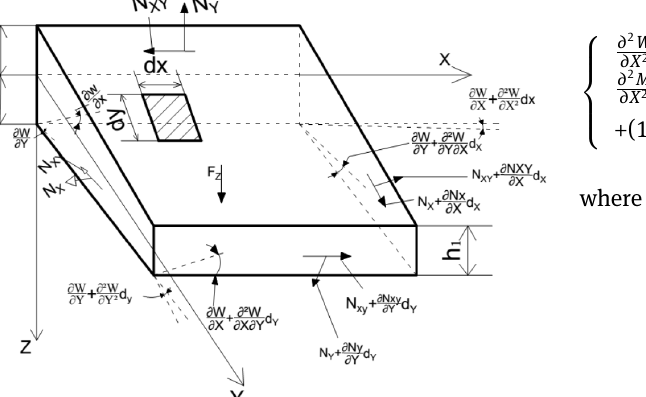
Figure 1: Element of a bent plate stretched and /or